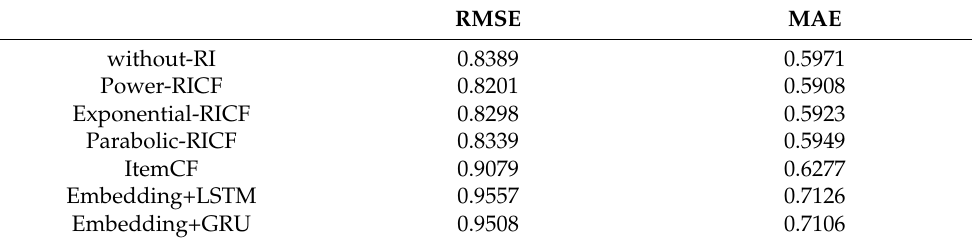
Table 5. RMSE of different comparative experiments on the DigitalMusic dataset.